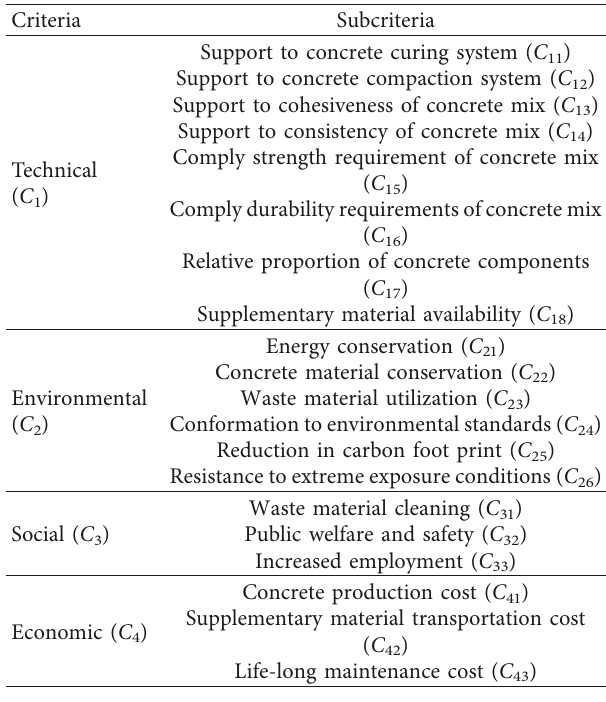
Table 1: Sustainability indicators along with subcriteria for se- lection of supplementary concrete